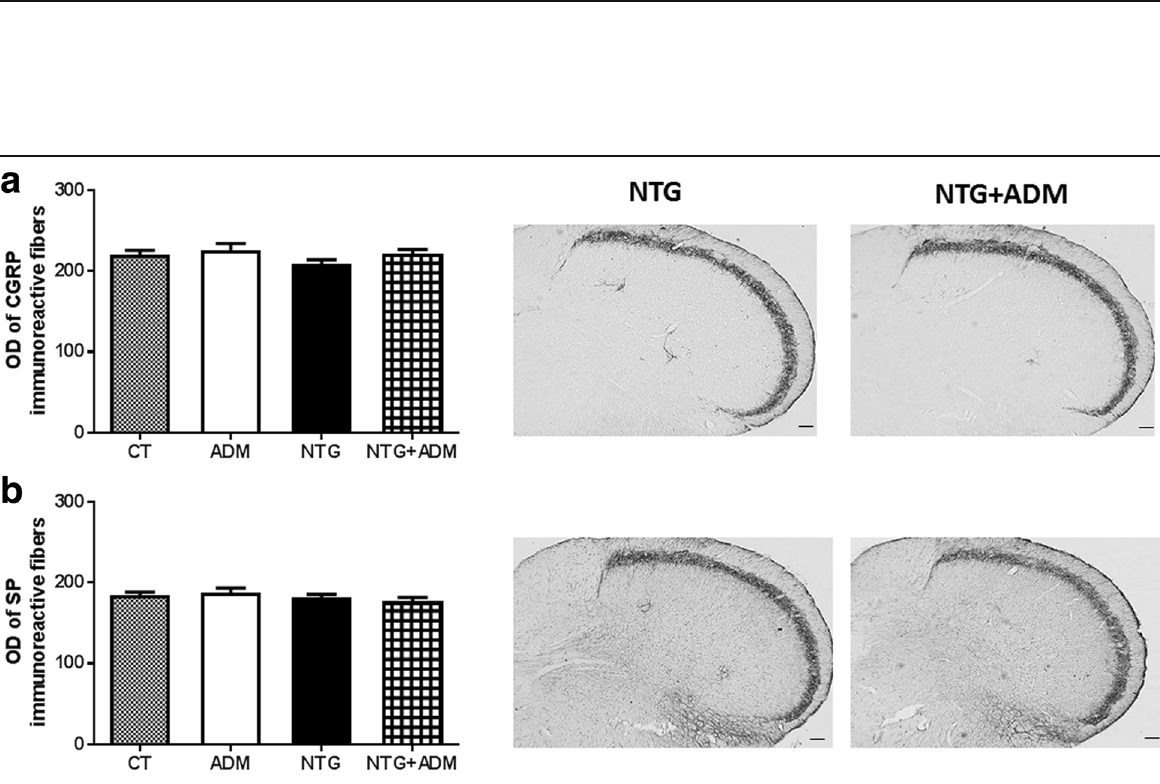
Fig. 3 Optical density (OD) values of CGRP and SP immunoreactive fibers in the TNC ipsilateral to the formalin injection. No significant differences were seen between NTG and CT groups for either CGRP ( a ) or SP ( b ). ADM_12 administration did not provoke any change in CGRP ( a ) and SP ( b ) expression either when associated to NTG vehicle (ADM group) or in combination with NTG (NTG + ADM group). Right: representative photomicrographs of CGRP ( a ) and SP ( b ) immunoreactive fibers in NTG and NTG + ADM group. Scale bar: 100 μ